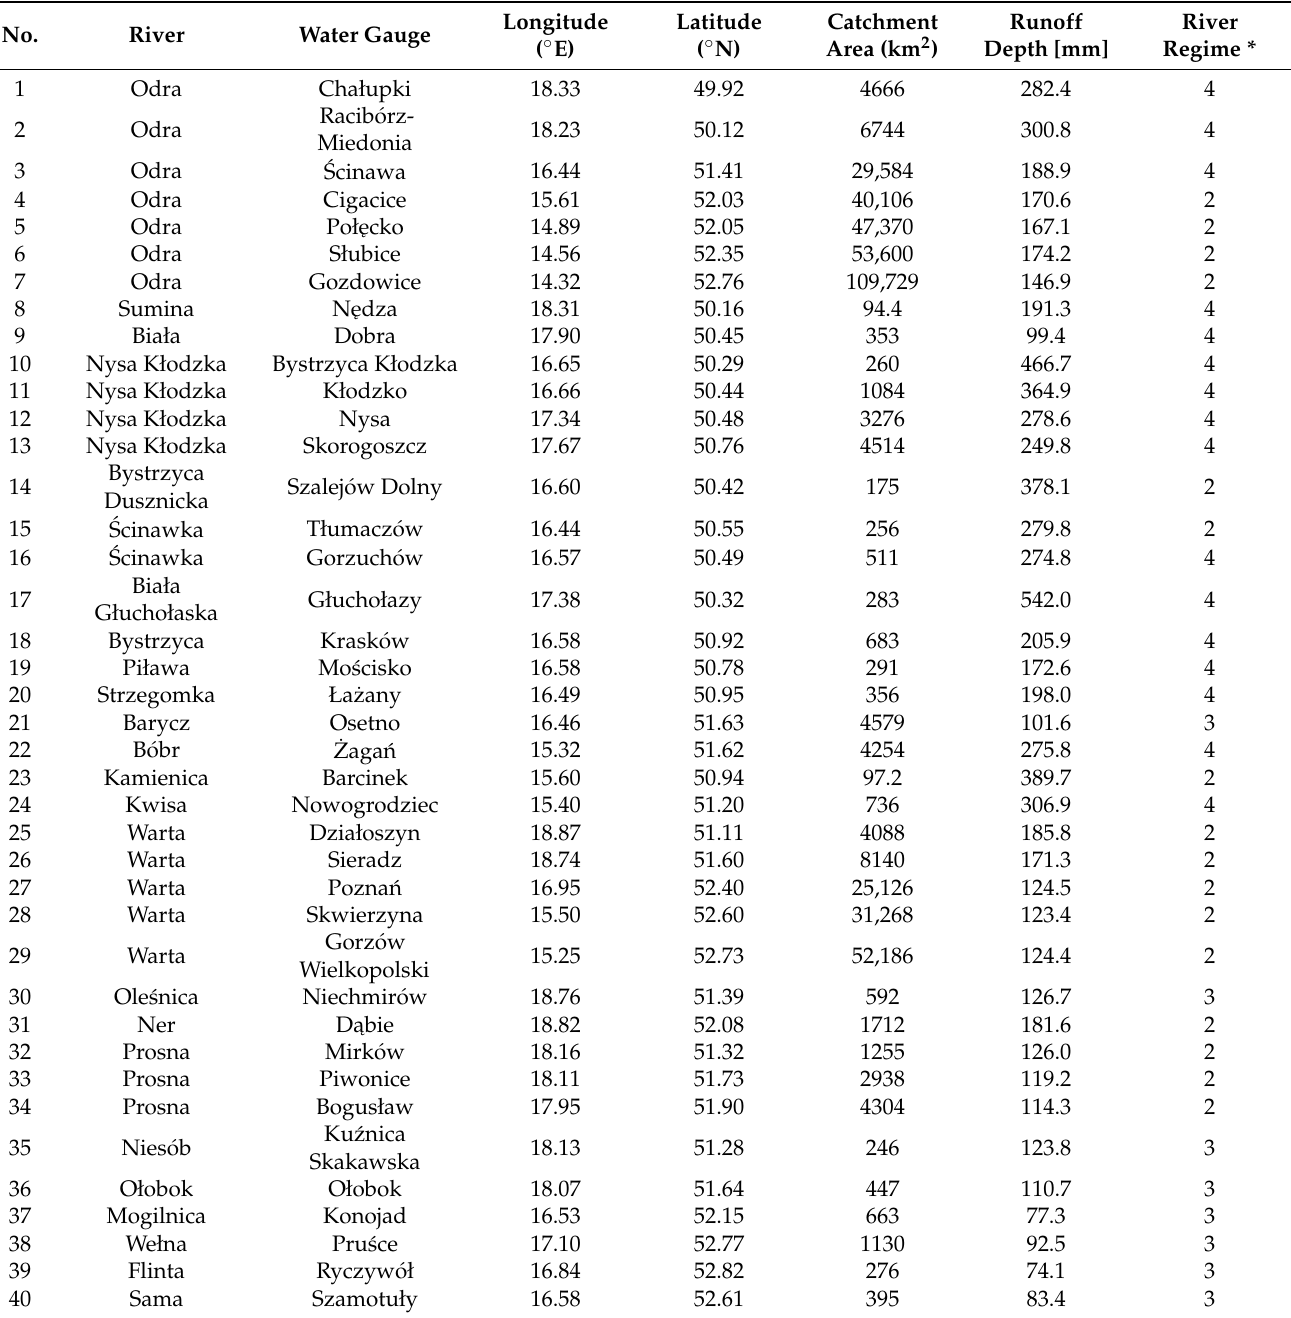
Table A1. Basic data on the studied